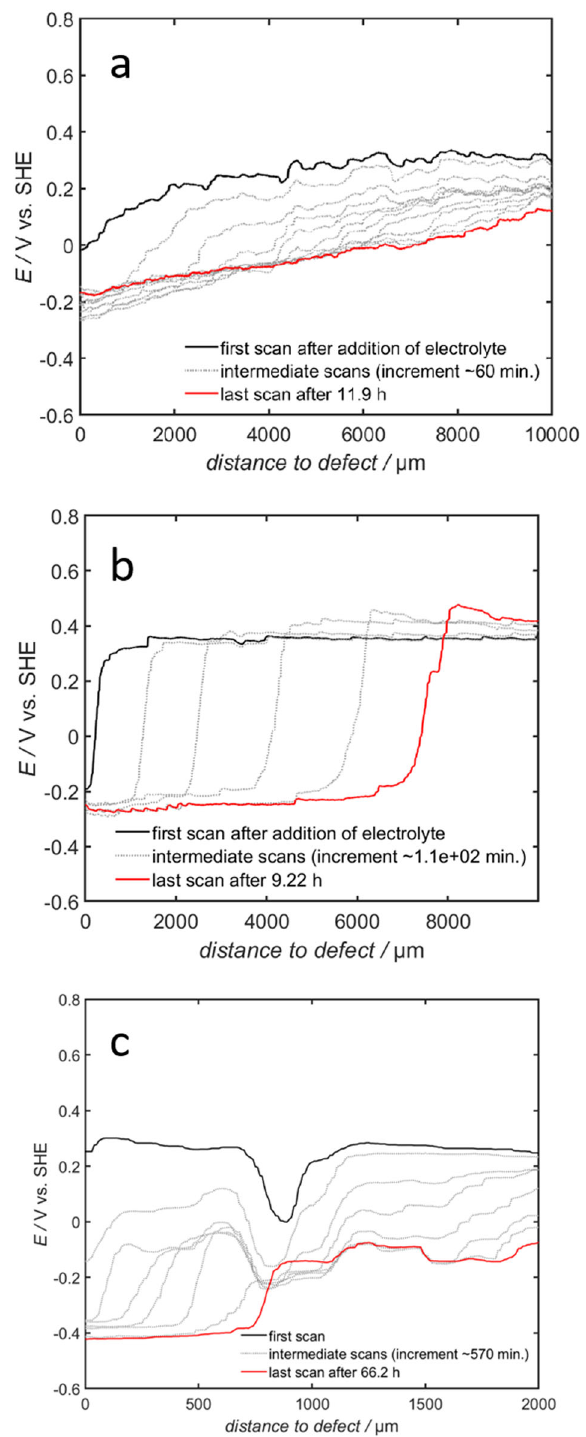
Fig. 5 Potential ( E ) vs. distance pro fi les obtained at various times during the progress of electrolyte-induced cathodic spreading on samples. a Chromium with a native oxide layer, b 10C-1.5O, and c